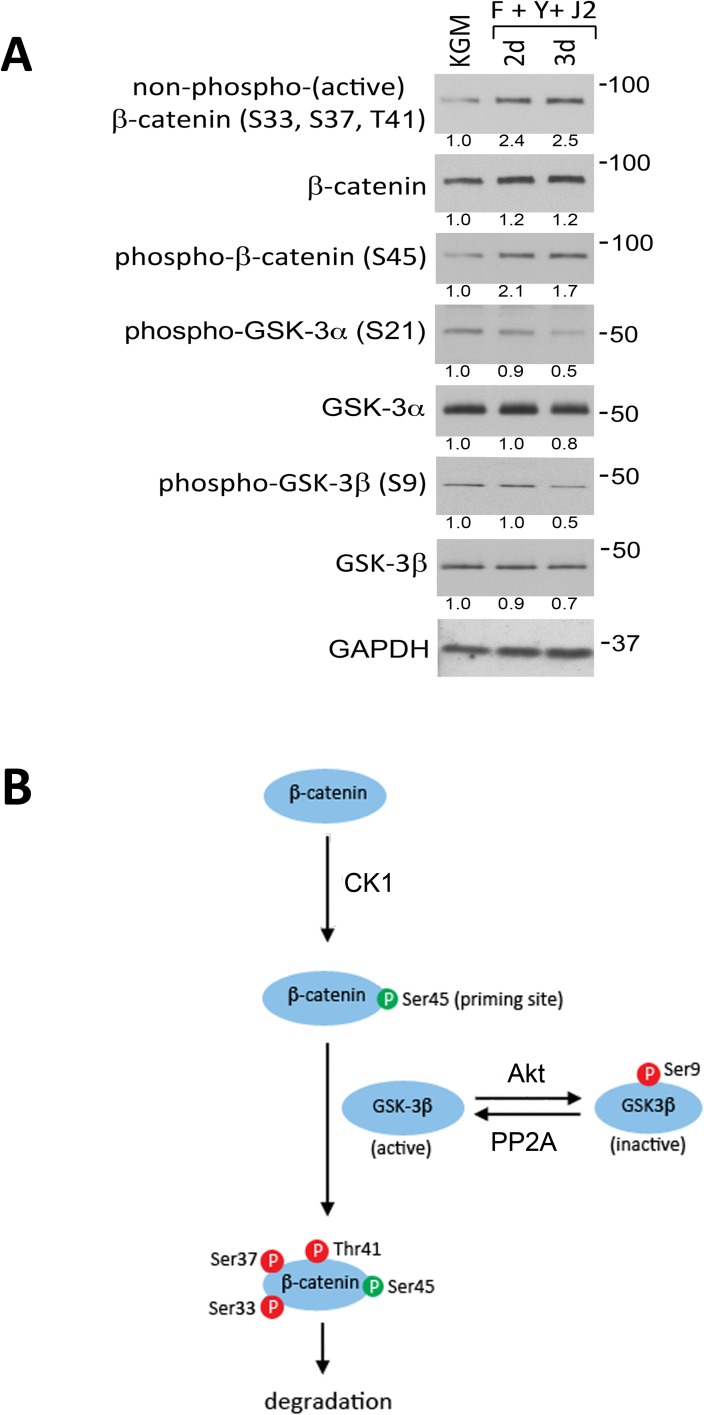
GSK-3 signaling during conditional reprogramming of HECs.(A) Western blot analysis of β-catenin and GSK-3 phosphorylation in whole-cell lysates prepared from HECs in KGM (KGM) after 3 d or after 2–3 d in CR culture (F+Y+J2). Phosphorylation sites are indicated in parenthesis. Lanes contain equal amounts of protein. Molecular mass markers (in kDa) are shown on the right. (B) Signaling pathway by which CK1, GSK-3, Akt and PP2A regulate β-catenin stability and activity. The β-catenin priming phosphorylation site at S45 is green; inhibitory and destabilizing phosphorylation sites are red.